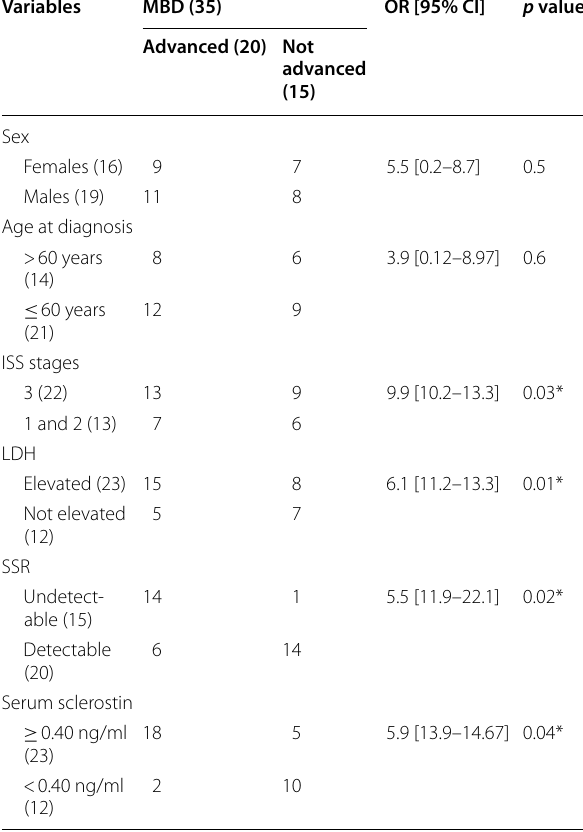
Table 5 Multivariate analyses between different risk factors